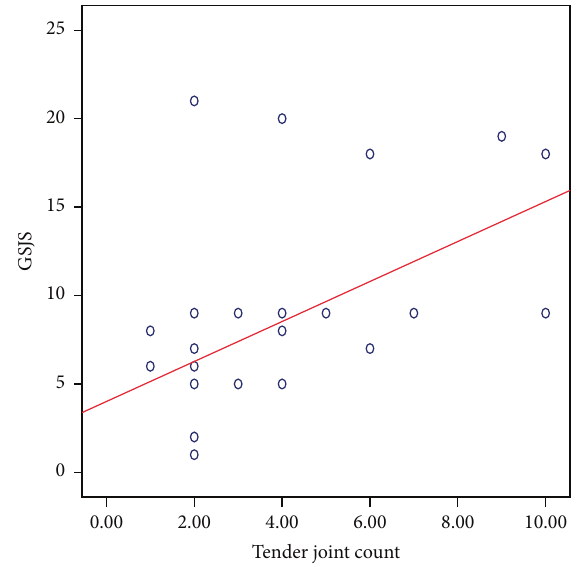
Figure 9: Relation between GSJS (taken from 28 MCP, PIP, and DIP joints)andTJCin30patientswithPsA.Spearman’s 𝜌 :0.484; 𝑃 :0.007 suggesting a significant correlation.